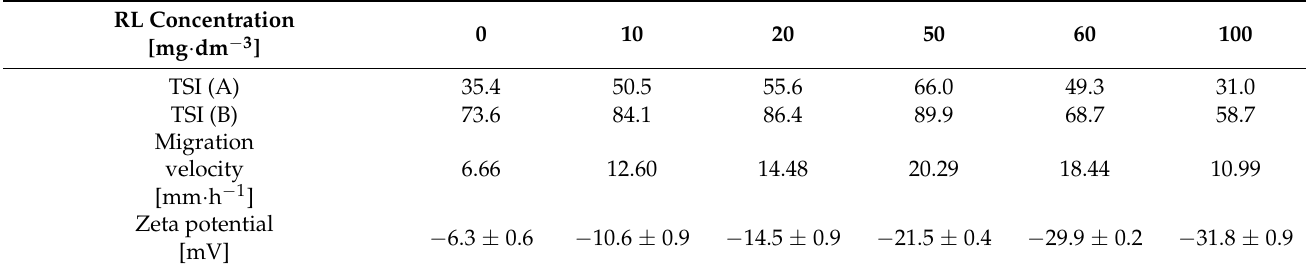
Table 1. Changes in TSI, calculated solid phase migration velocity and zeta potential values for different RL concentrations. TSI (A) after 60 min and TSI (B) after 180 min. The results correspond to the curves in Figures 7 and 8 accordingly. RL